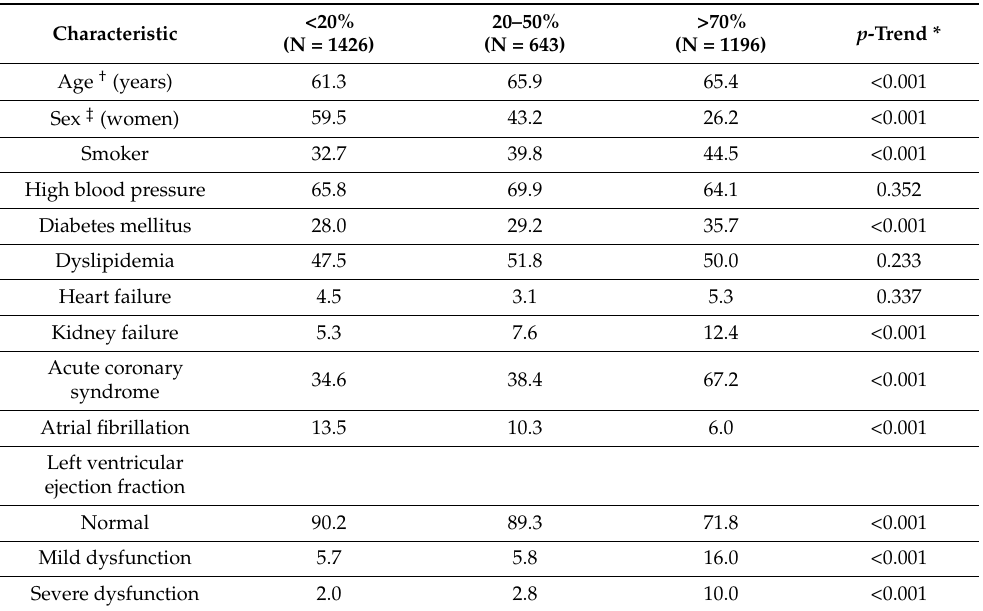
Table 1. Adjusted baseline characteristics of the participants, according to the degree of the coronary artery involvement.